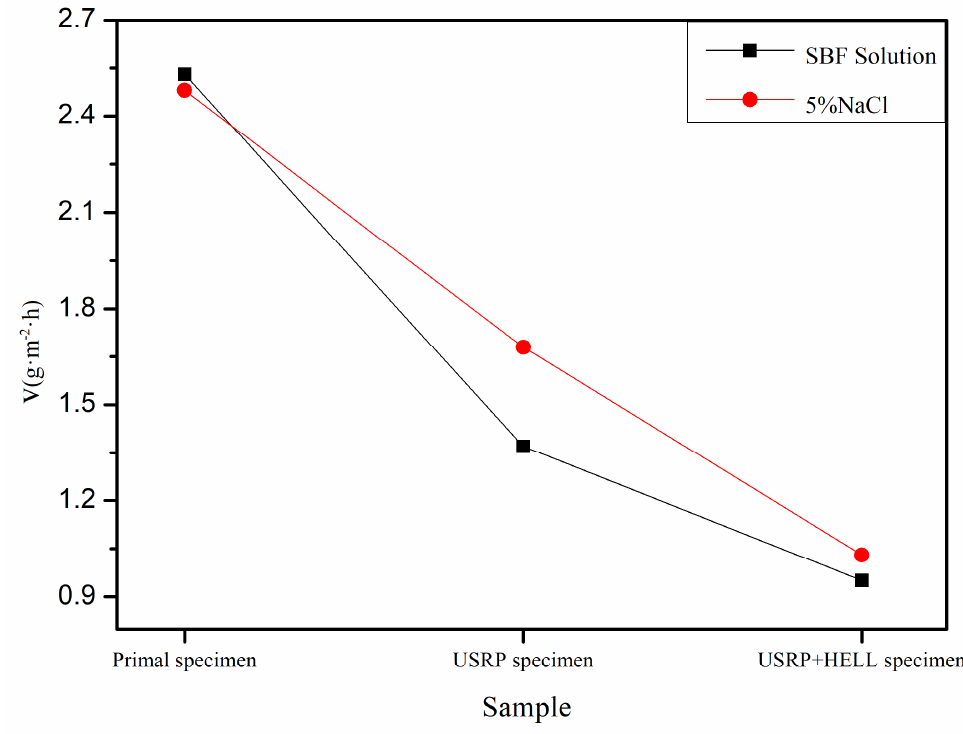
Figure 7. Corrosion information of magnesium alloy specimens after immersion experiments in two